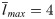
Schematic of discretized version of Eq 1 for the case of filaments having length four subunits (l¯max=4).The subunits in solid circles can generate a branch of length l¯(y¯,t) that reaches the open circle (x¯,y¯). x¯ and y¯ are dimensionless coordinates normalized by a/2, where a is the step size per added subunit. See Eq. S30 for definition of l¯(y¯,t).